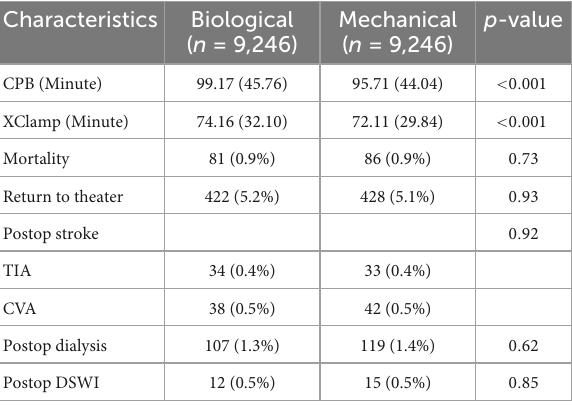
(female sex, urgent operation, peripheral vascular disease, and pre-operative atrial fibrillation) prostheses (CI, confidence interval, BMI, body mass index, LVEF, left ventricular ejection fraction, PVD, peripheral vascular disease, AF, atrial fibrillation). Pre-operative characteristics